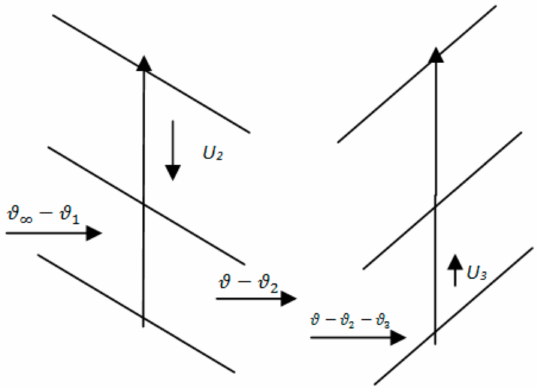
Figure 8. Water velocities before the first and second grid. The force acting on the grid along the OY axis is: F y = 0.5 C y lb ρ W 2 . The same force acts on water and creates the velocity U 1 . Then it is equal to ntb ρϑ ∞ U . C y W 2 l Thus U 1 = sin µ 2 t ϑ ∞